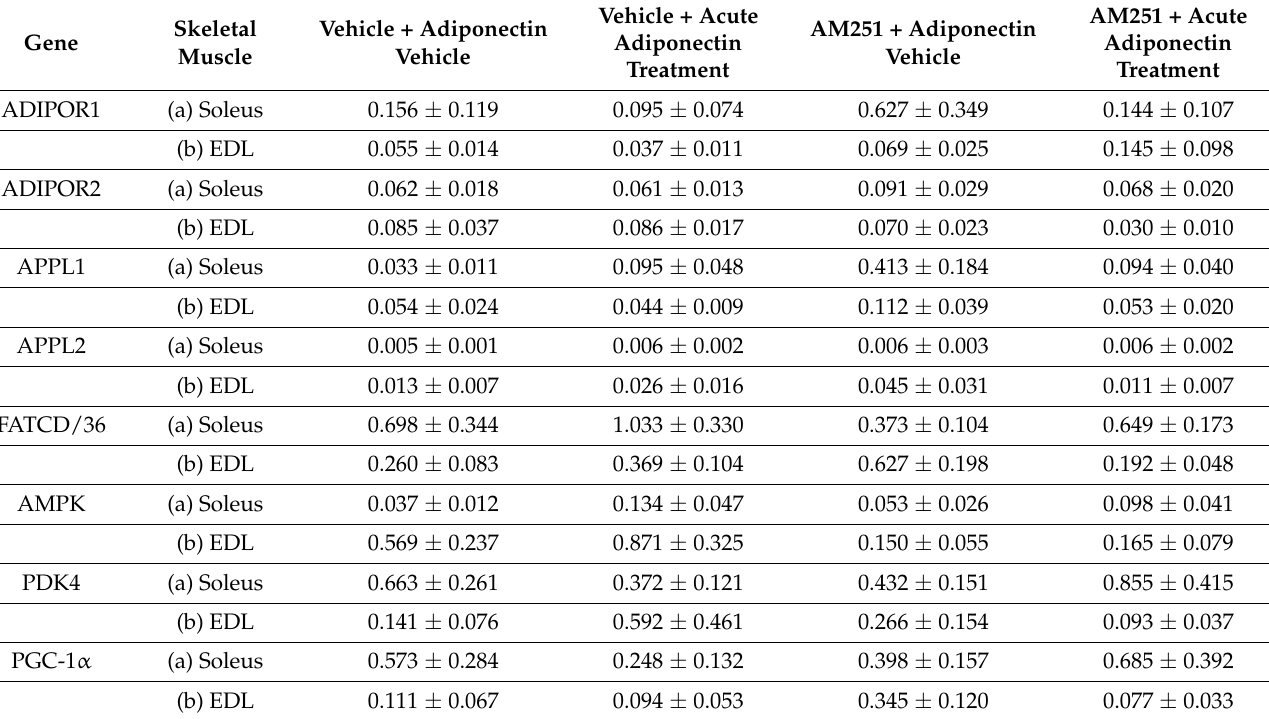
Table 3. The effects of AM251 and acute adiponectin treatment on skeletal muscle gene expression in HFD rats. The soleus and EDL were obtained from HFD rats treated with vehicle or AM251 for 6 weeks and exposed ex vivo to 0.1 µg/mL of adiponectin (n = 7–9) or adiponectin vehicle (n = 6–9) for 30 min. All data are presented as a mean ± SEM in arbitrary units (normalized to housekeeping genes, GAPDH, cyclophilin and β -actin.).